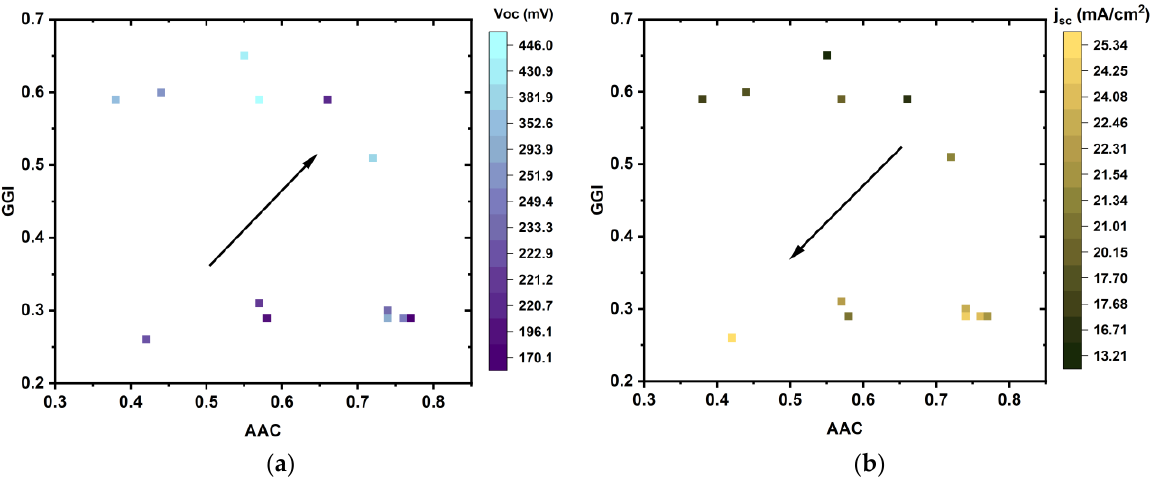
Figure 7. ( a ) Open circuit voltage V oc , and ( b ) short circuit current density j sc of ACIGSe solar cells as a function of GGI and AAC ratios (arrows indicating increasing trends).